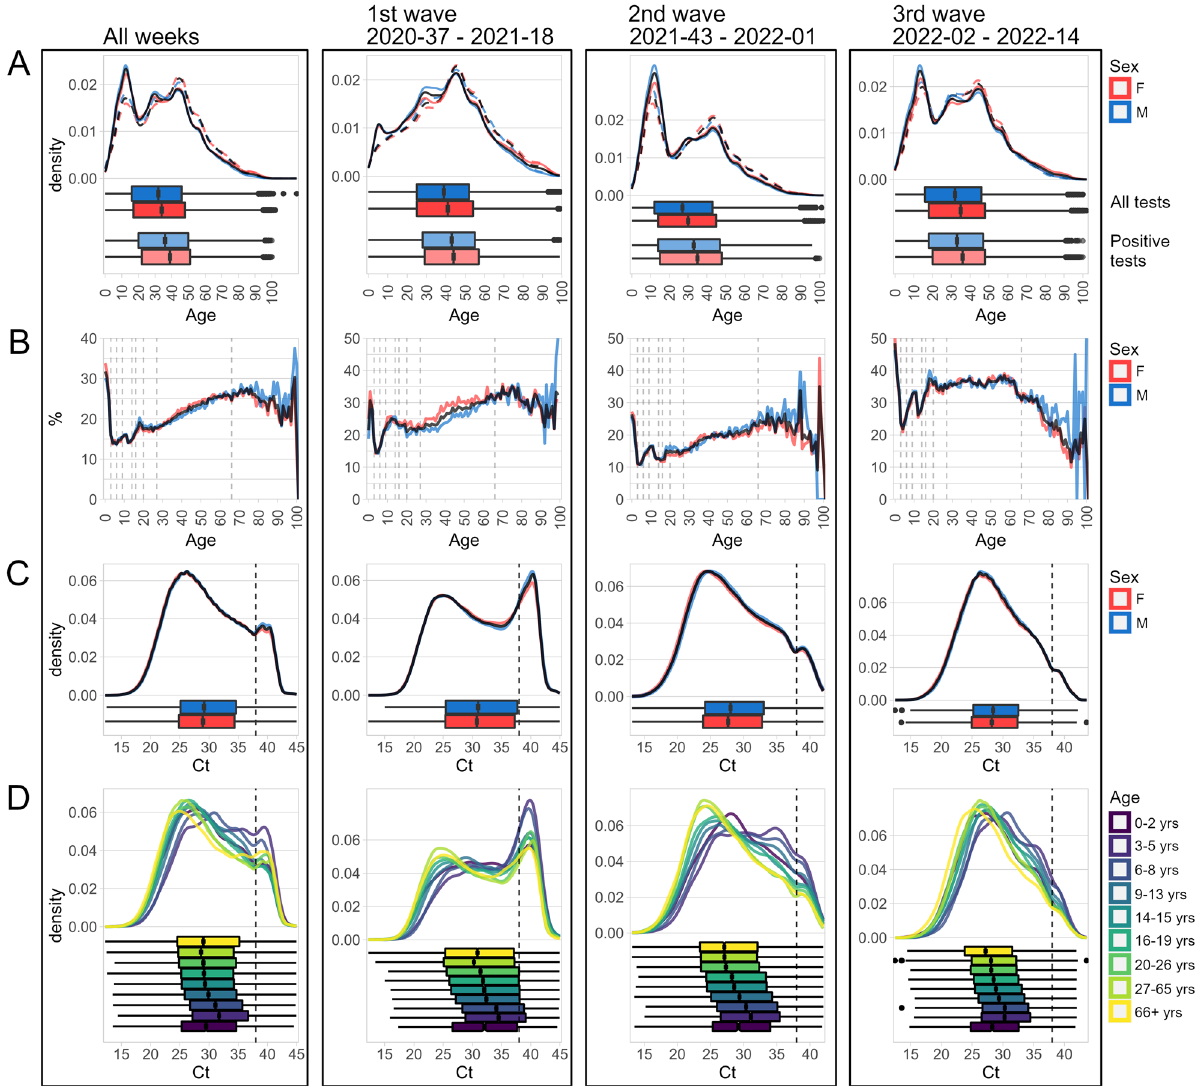
Figure 2. ( A ) Age distributions of all tested individuals; all tests (solid lines and darker boxplots) and positive tests (dashed lines and lighter boxplots). ( B ) Positivity of the tests (in %) in relation to the age of the tested individuals. Dotted vertical lines show limits for the age categories. ( C ) Ct distributions of all tests. Dotted vertical line shows threshold used for the test positivity. ( D ) Ct distributions of all tests. Data is divided according to the age of the individuals. Data in ( A – C ) represents all tests (black), tests performed in females (red), and tests performed in males (blue). Data in ( A , C , D ) is shown as density plots supplemented with